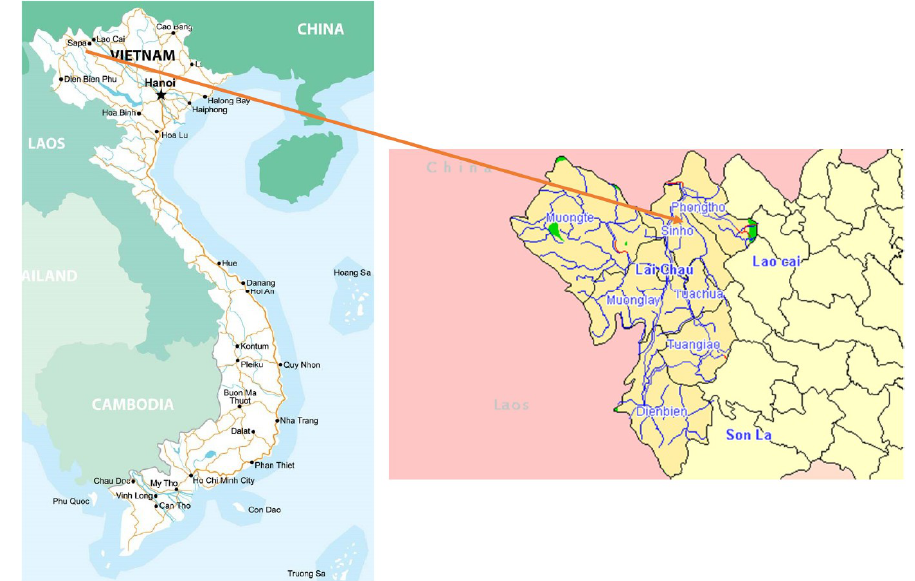
Figure 1. Location of Namxe rare earth deposit [7,8].